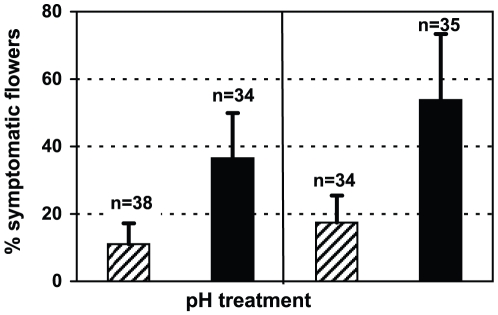
Percentage of flowers with fire blight symptoms after inoculation at acidic or neutral pH conditions.Percentage of symptomatic flowers inoculated with E. amylovora suspension adjusted to pH 4 (striped bars) or pH 7 (black bars) in two independent experiments (left and right half of diagram). Bars represent mean percentages of 3 replicate boxes with 11–14 inoculated detached apple flowers. Total flower numbers are indicated above bars. Mean percentages of symptomatic flowers are significantly different between pH treatments on a p<0.05 level (T-test).